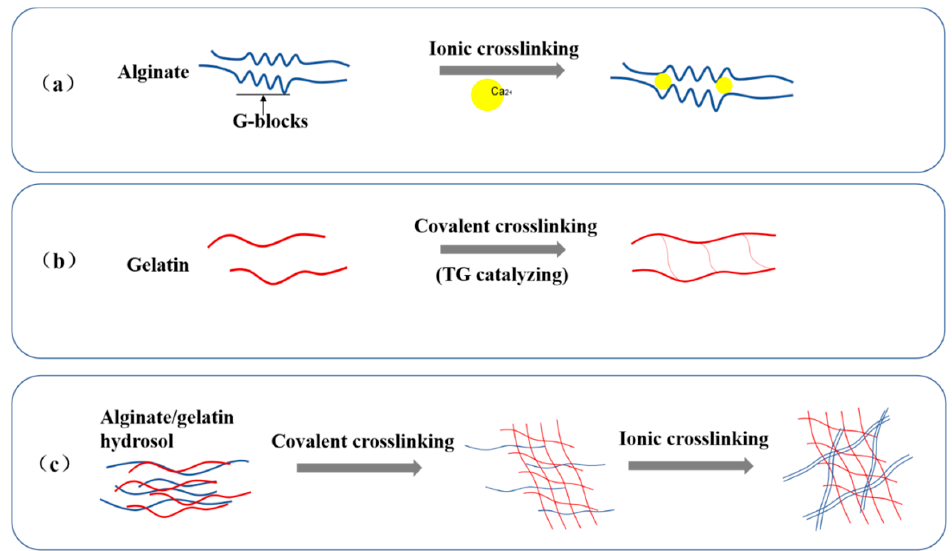
Figure 2. Chemical description of ionic crosslinking of alginate molecules, covalent crosslinking of gelatin molecules, and both covalent and ionic crosslinking of alginate/gelatin molecules. ( a ) G-blocks in two alginate chains are chemically (i.e., ionic) crosslinked by Ca 2+ . ( b ) Transglutaminase (TG) catalyzed covalent linkages between two gelatin molecules. ( c ) An interpenetrating network in an alginate/gelatin hydrogel formed through both TG covalent and Ca 2+ ionic crosslinks.